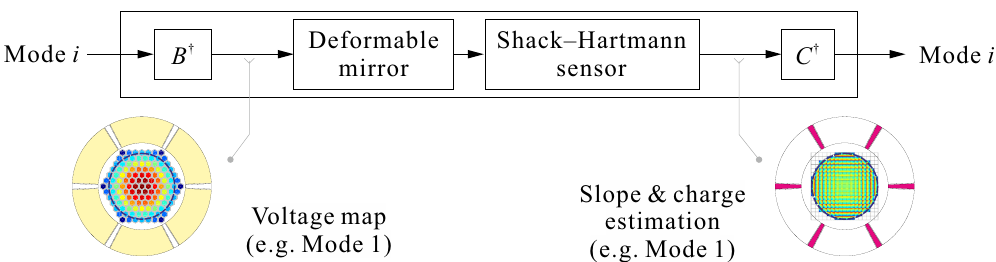
Figure 13. Block diagram of the modal input–output transfer function (illustrated for mode